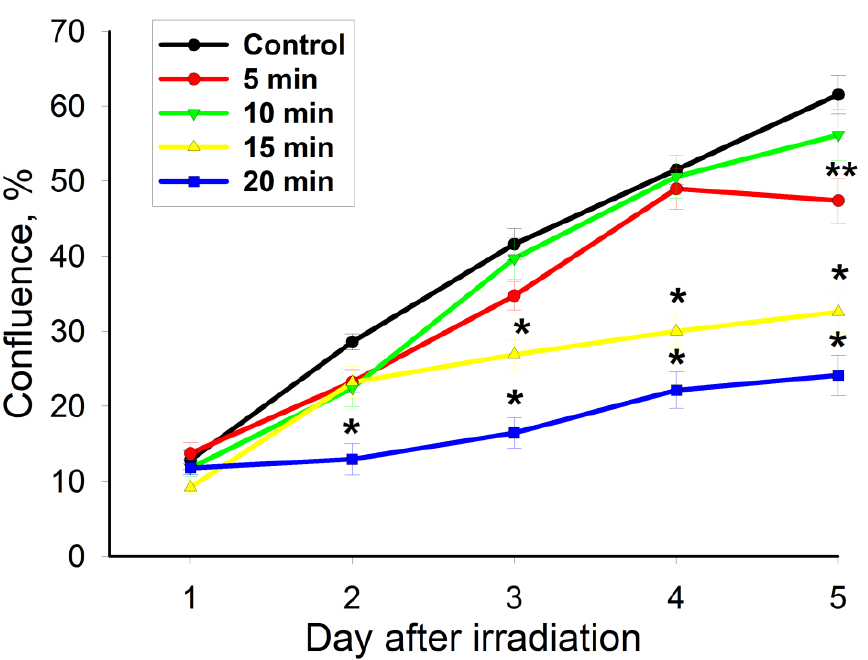
Figure 2. The density-increase dynamics of normal MSC cells after CAAP treatment at different exposure times (5 min, 10 min, 15 min and 20 min) and in the control experiment. * p < 0.001, ** p < 0.01.